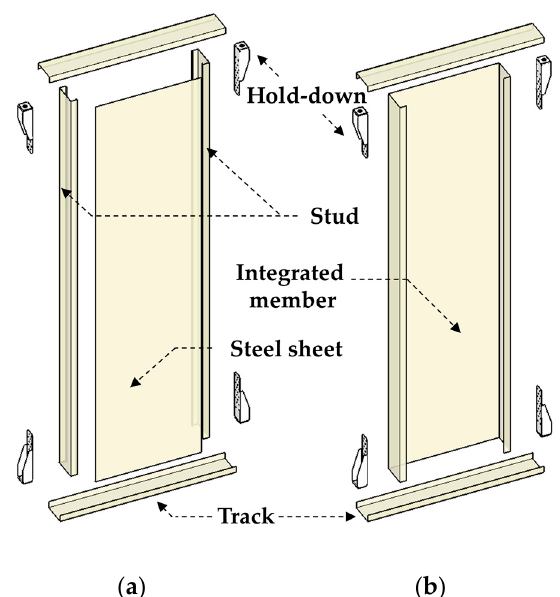
Figure 1. Conceptual diagram of an integrated panel system derived from a steel-sheathed wall system: ( a ) Steel-sheathed wall system, ( b ) Integrated panel system.